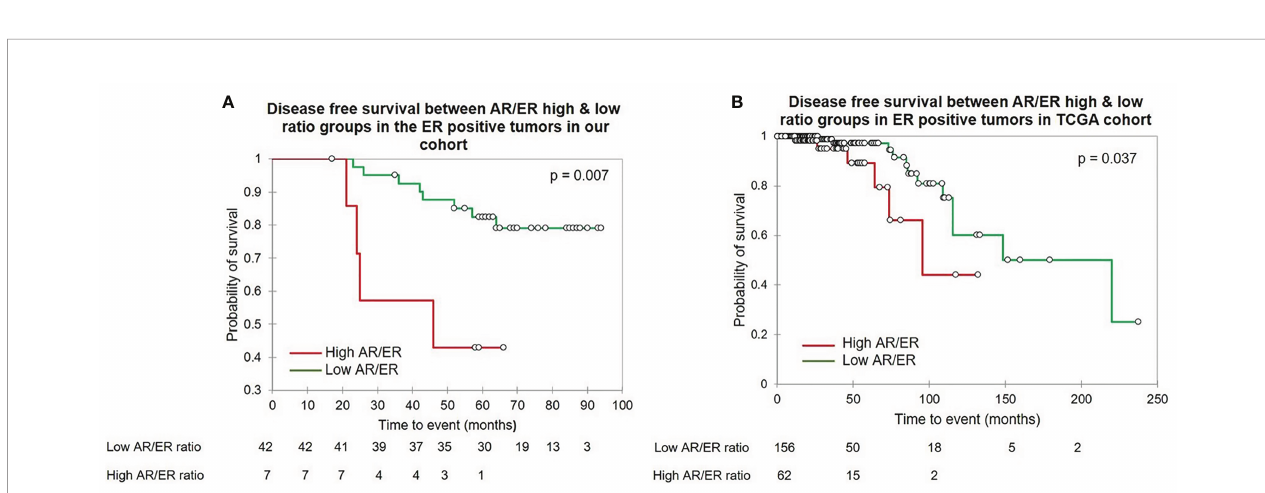
FIGURE 2 | The Kaplan – Meier survival analysis in the ER positive patients ≤ 50 years of age. (A) The disease free survival between the high vs low AR/ER ratio groups in our cohort. (B) The disease free survival between the high vs low AR/ER ratio groups in the TCGA